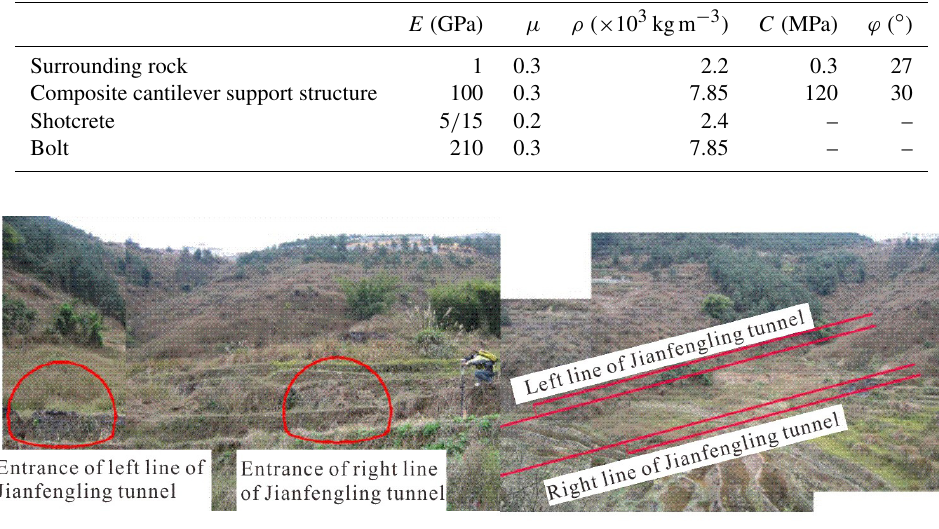
Figure 3. Topography of the tunnel test section and comparison section.